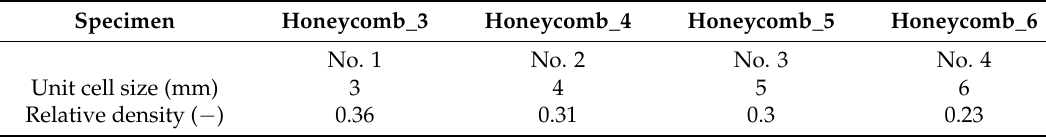
Table 1. Relative density of the developed honeycomb